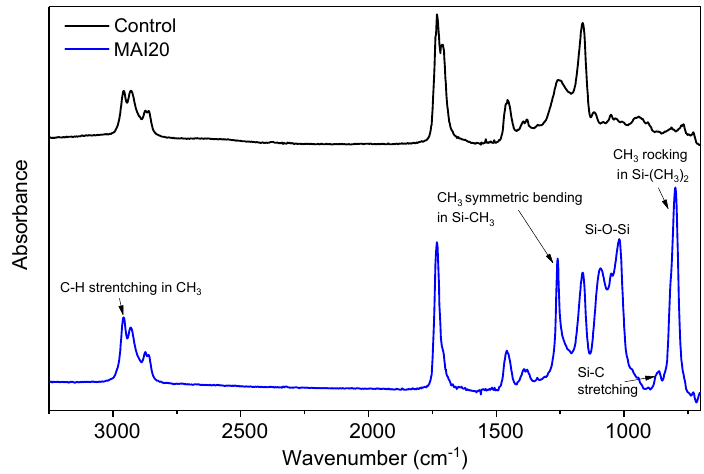
Figure 3. FTIR spectra of Control and MAI20 PSAs.